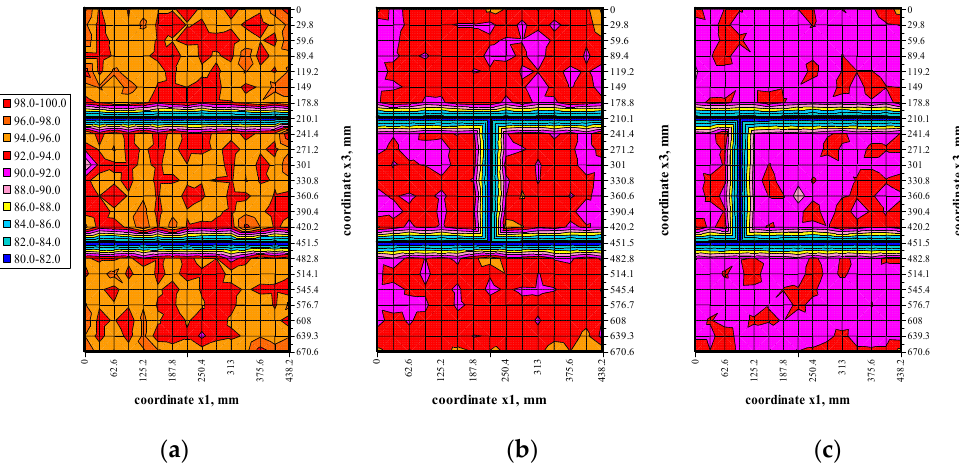
Figure 13. Results from measuring passing time of the ultrasonic wave under the load σ 3 = 0.75 σ 3max : ( a ) model I-1, ( b ) model II-1, ( c ) model III-1. Basic results in the form of mean time of wave propagation for all points are compared in Table 4. Table 4. Results from measuring propagation of ultrasonic waves. Model